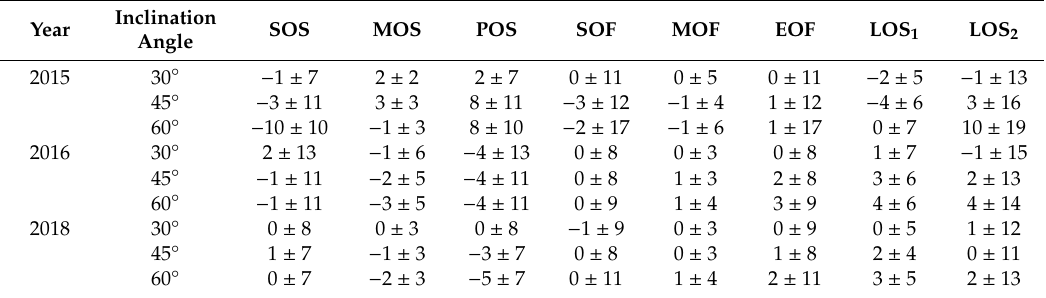
Table 3. Comparisons of the phenophases (number of days, mean ± 95% confidence interval) estimated from 30 ◦ , 45 ◦ , and 60 ◦ of inclination-angles with reference to 15 ◦ in the three measuring years. The fields of view by green chromatic coordinate from camera were constrained in the same area for all images.